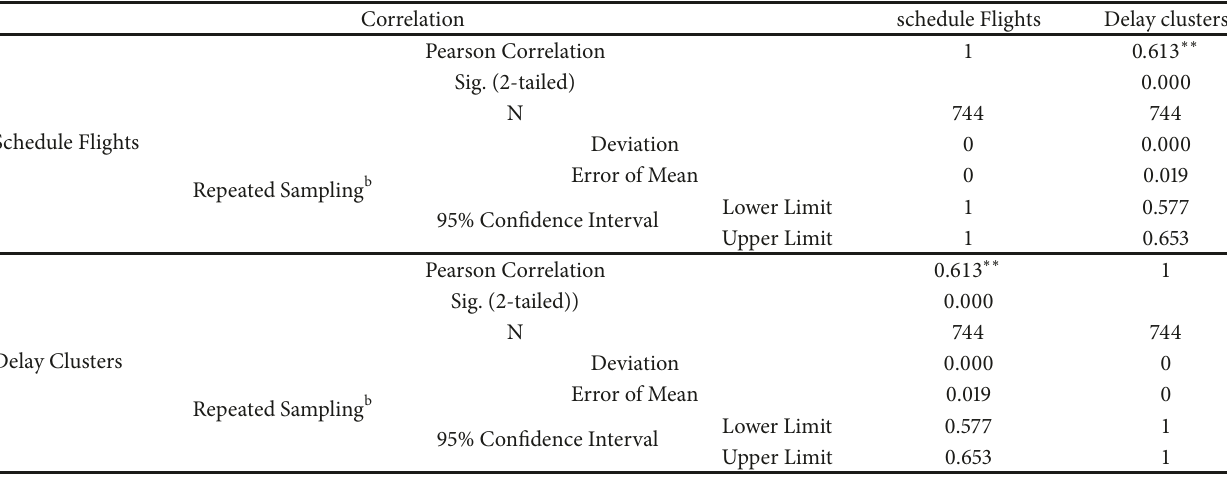
Table 1: Correlation between delay clusters and departure schedule flights.